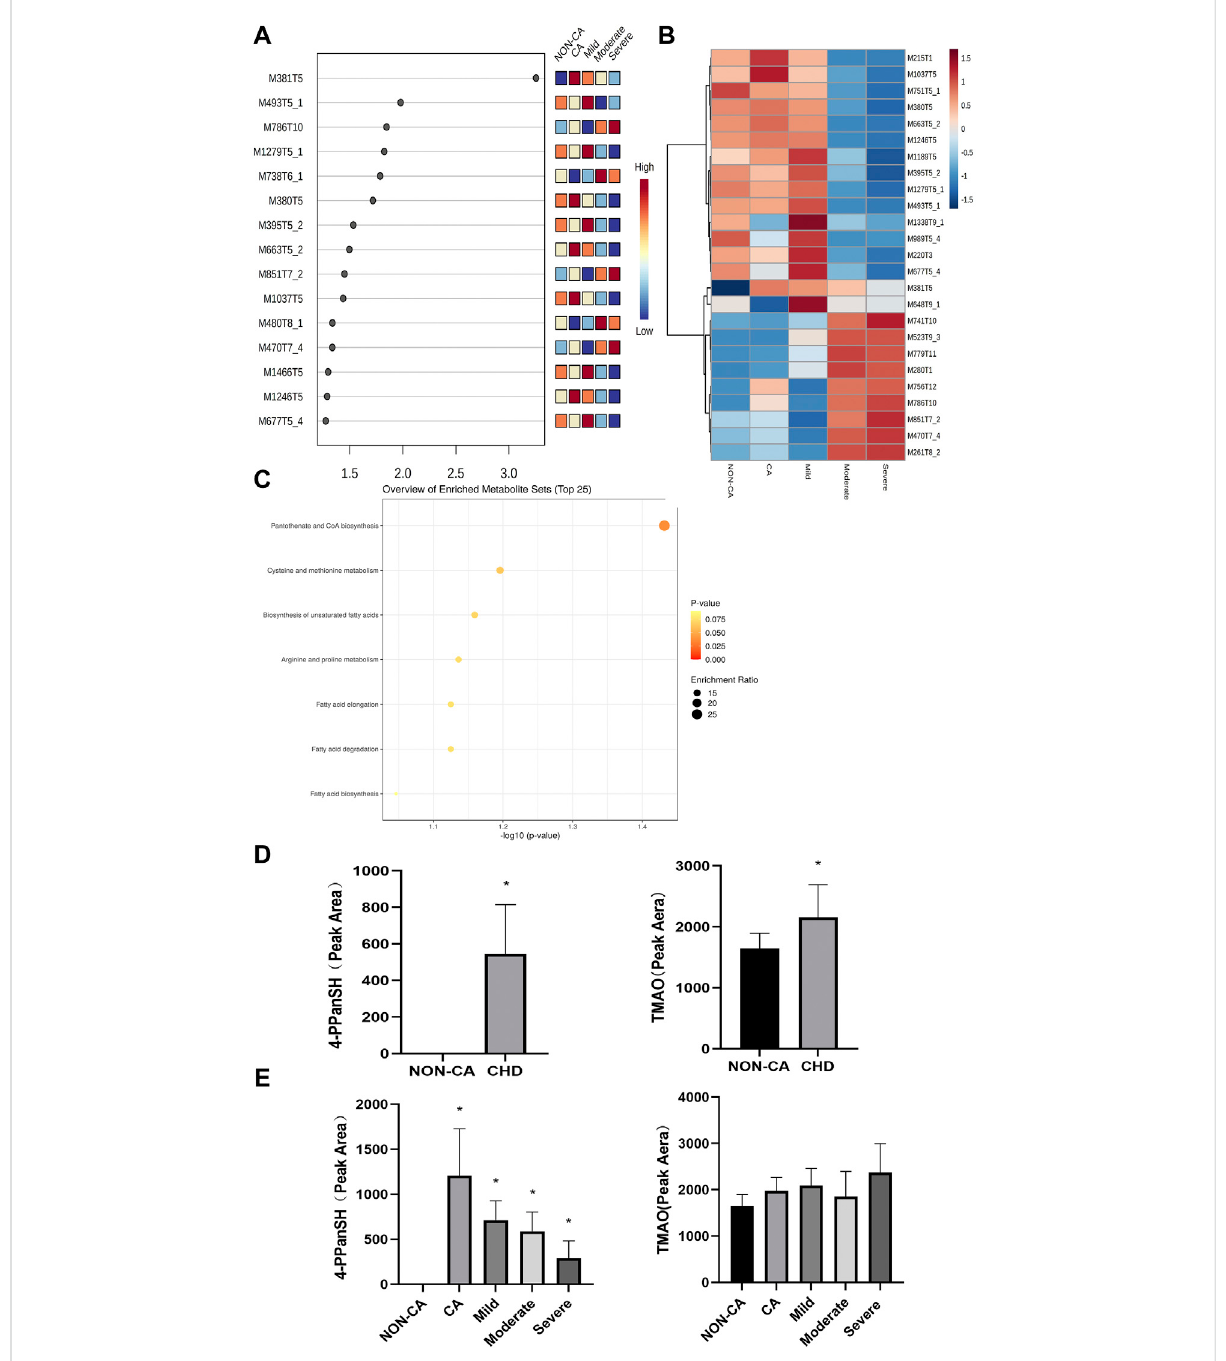
FIGURE 1 4-PPanSH was associated with various degrees of CHD. (A) The VIP score analysis showed that M381T5 was the potential diagnostic marker in fi ve groups. (B) Cluster analysis in the discovery cohort. (C) Enrichment analysis for differential metabolites revealed that coenzyme A biosynthesis is the most relevant signaling pathway. (D) The results of the semiquantitative analysis showed that both 4-PPanSH and TMAO were apparent differences in the NON-CA and CHD groups. (E) Semiquantitative analysis showed that 4-PPanSH was associated with different severity of CHD. *Indicates p < 0.05 compared to the NON-CA